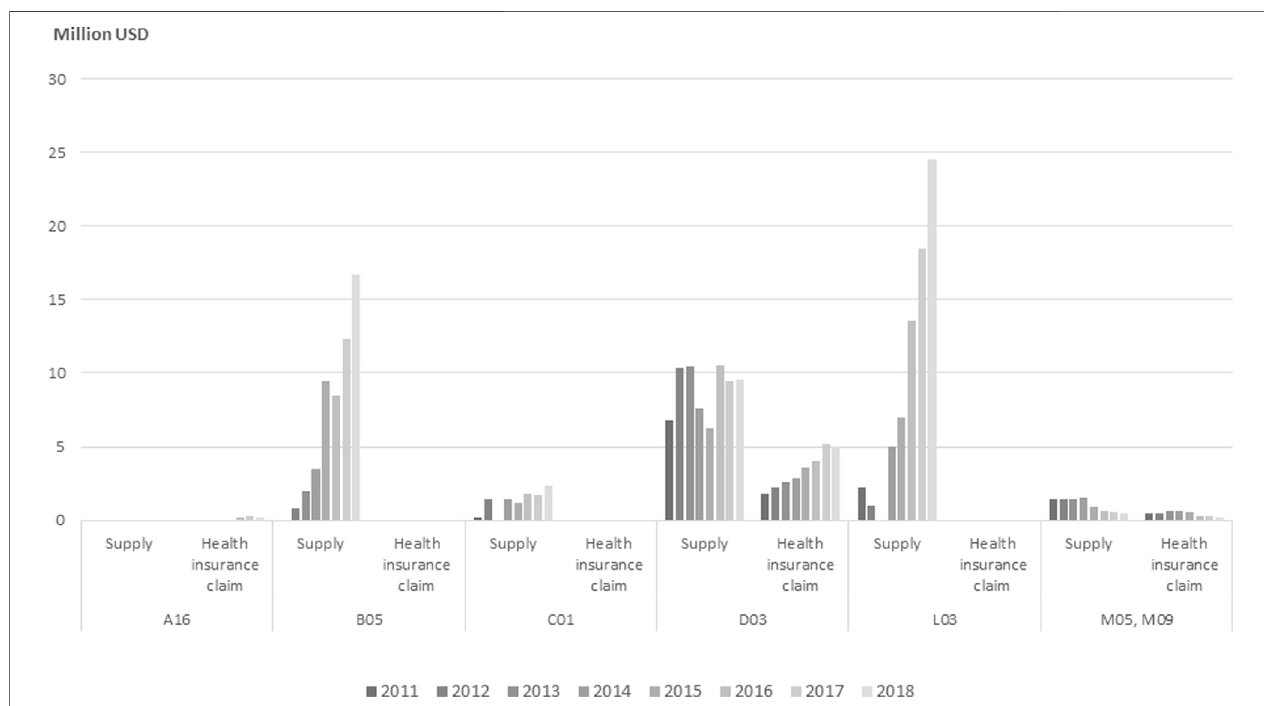
FIGURE2 | Annual expenditure ofapproved and reimbursed celltherapy products by ATC class from 2011to 2018. Note: ATC, anatomical therapeutic chemical. A16 (Other alimentary tract and metabolism), B05 (Other blood products), C01 (Cardiac therapy), D03 (Preparations for treatment of wounds and ulcers), L03 (Other immunostimulants), M05, M09 (Musculo-skeletal system). No. of approved, No. of reimbursed drugs — A16 (1,0), B05 (2,0), C01 (1,0), D03 (7,2), L03 (2,0), M05 and M09 (2,1).